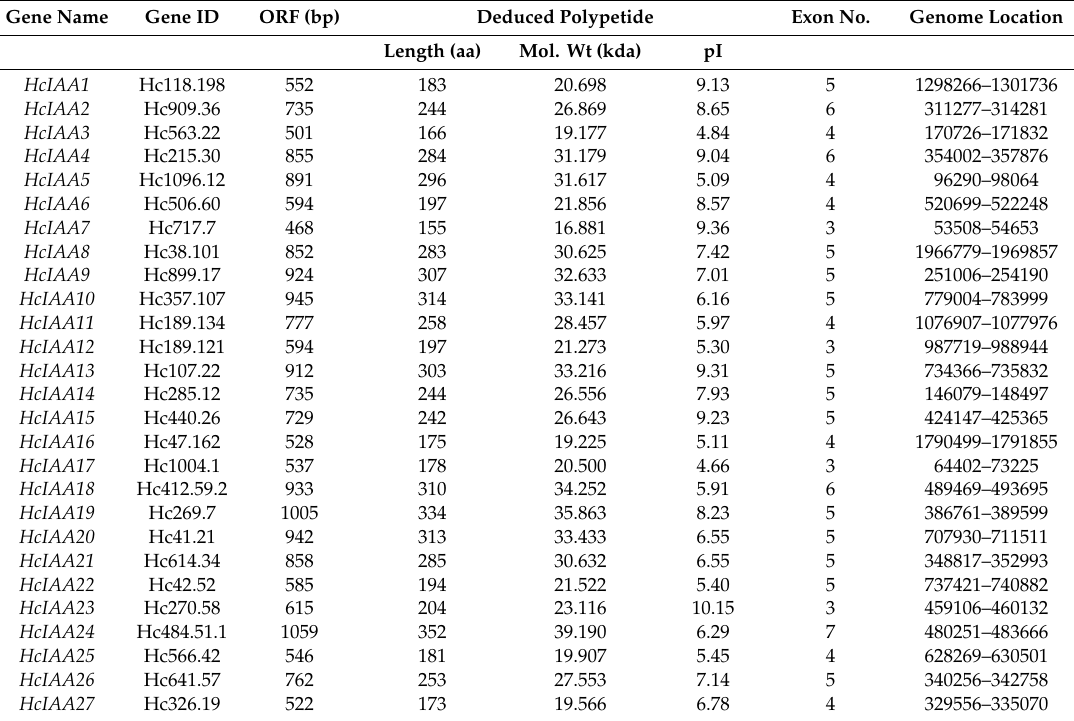
Table 1. Description of the Aux / IAA gene family in Hedychium